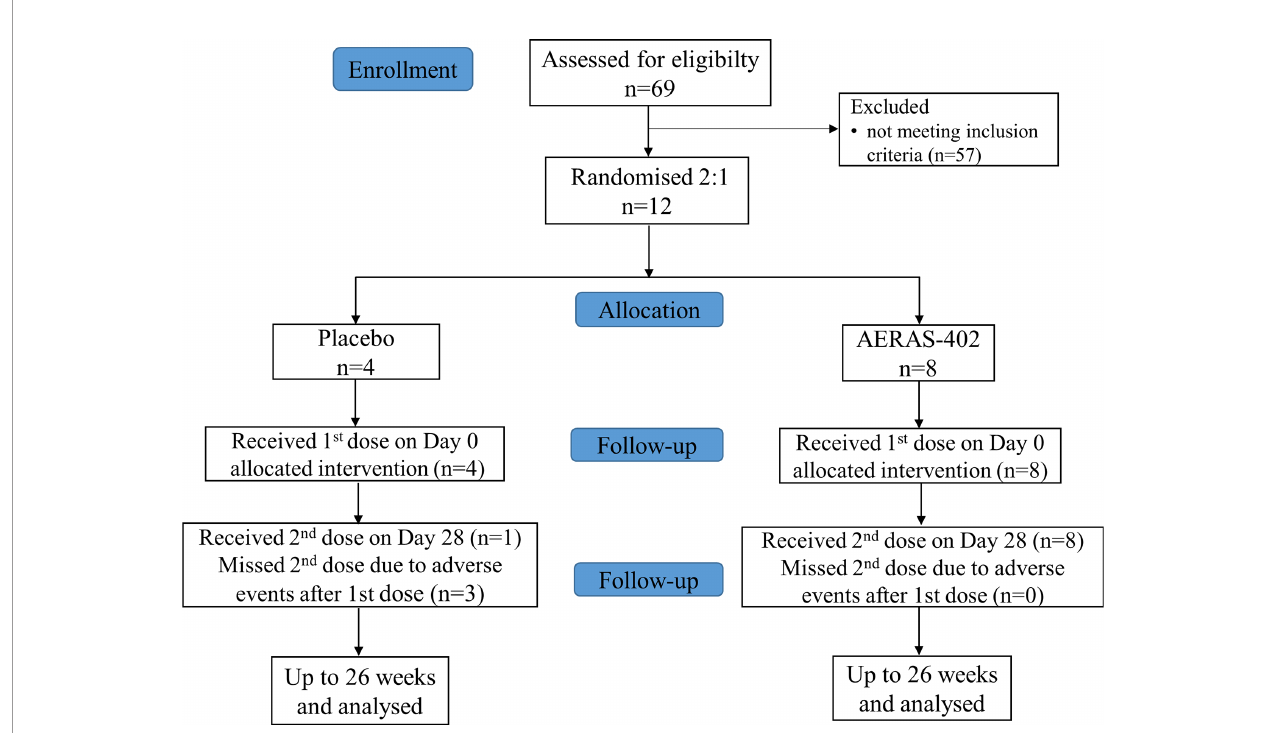
FIGURE 1 | Study fl ow